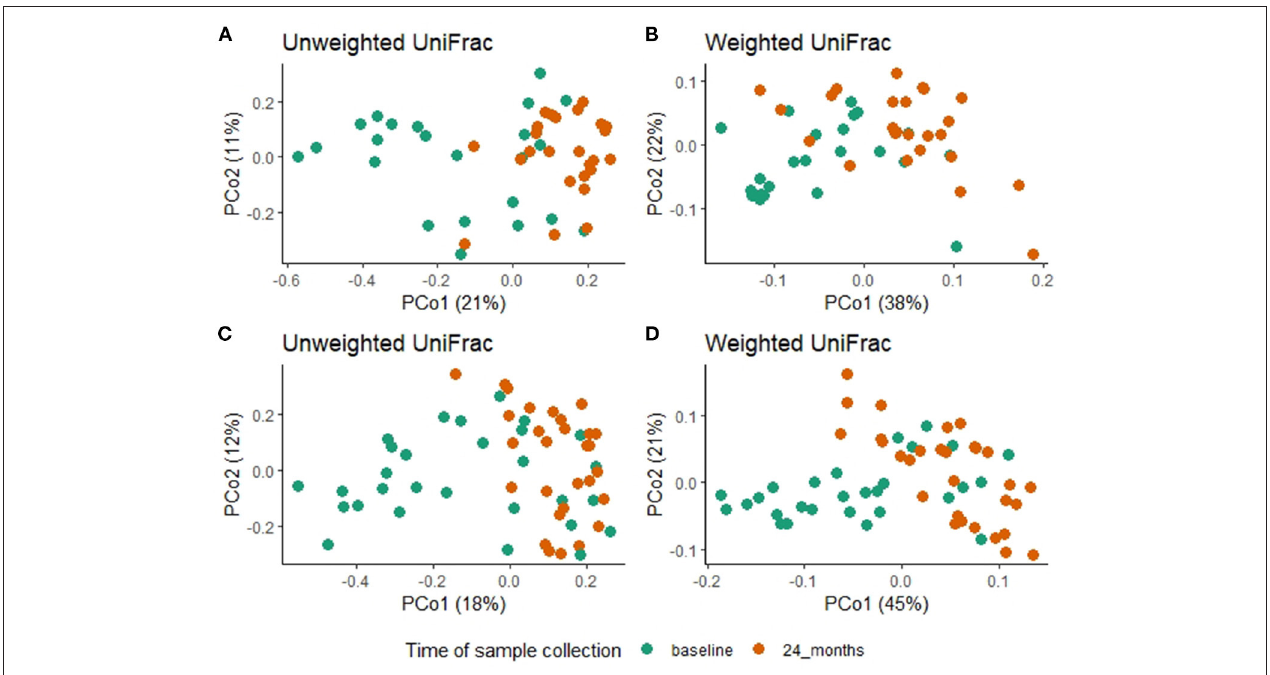
FIGURE 3 | Overall fecal microbiota composition differences between baseline and 24-month fecal samples in the azithromycin (A,B) and placebo (C,D) arms. (A) PCoA plot of unweighted UniFrac distances [PERMANOVA, R 2 = 0.1, F = 5.09, P = 0.001] (B) PCoA plot of weighted UniFrac distances [PERMANOVA, R 2 = 0.1, F = 5.1, P = 0.001], (C) PCoA plot of unweighted UniFrac distances [PERMANOVA, R 2 = 0.07, F = 4.01, P = 0.001] (D) PCoA plot of weighted UniFrac distances [PERMANOVA, R 2 = 0.16, F = 11.87, P = 0.001]. In all the PCoA plots above (A–D) , PCo1 explained the most variation and baseline fecal samples clustered in the negative space of PCo1 while 24-month fecal samples clustered in the positive space of PCo1.